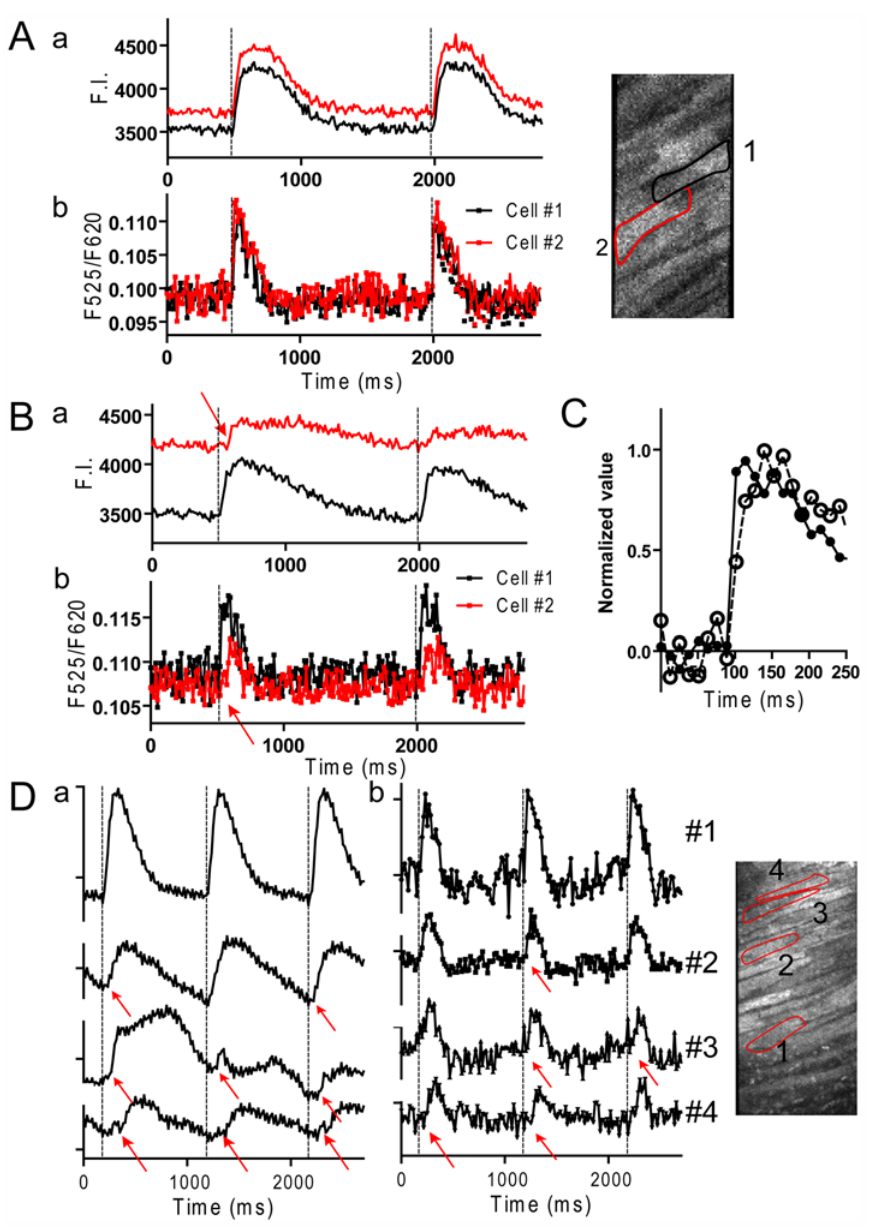
Figure 3. Ca 2 + and action potential signals in muscles showing desynchronized Ca 2 + transients. A . Signals under control conditions. B . Signals after the pacing protocol in non-flowing solution. Records in A and B were obtained from the same muscle. C . Overlay of the raising phase of the action potential in the whole field of view under control condition and after the pacing protocol shown in A and B . D . Another example of desynchronized Ca 2 + transients and action potential signals. a : Ca 2 + signals. b : action potential signals. Red arrows indicate delayed responses in